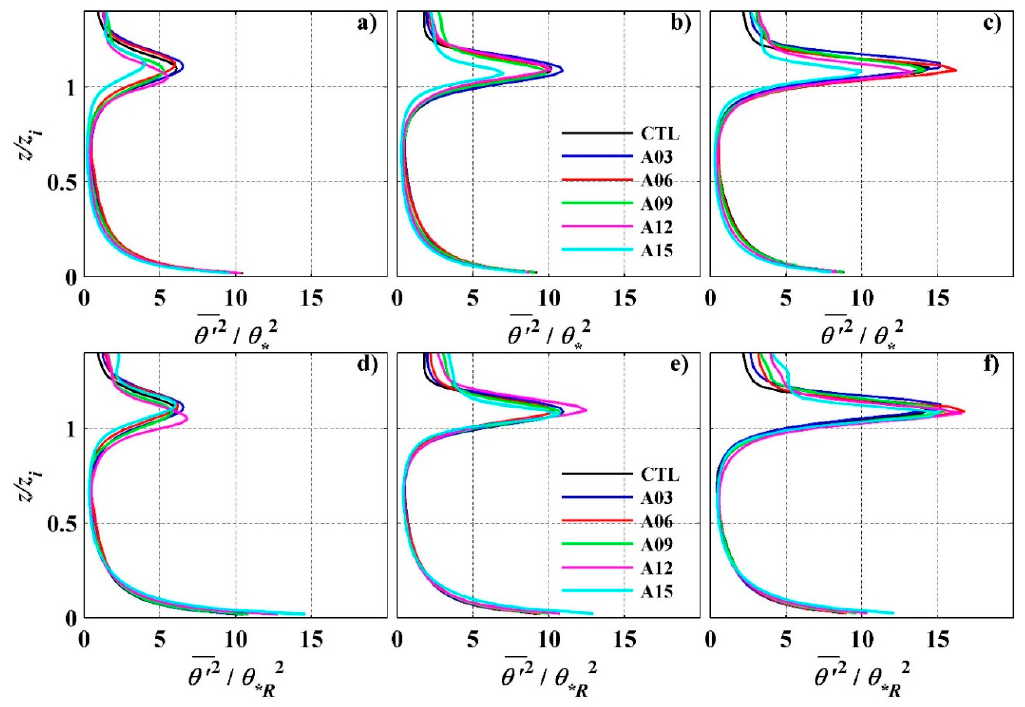
Figure 13. A comparison of profiles of the vertical velocity variance ( w (cid:48) 2 ) normalized with traditional convective velocity scale w ∗ : ( a – c ) and modified convective velocity scale w ∗ R : ( d – f ) for three different stratification strengths in the free atmosphere. For notation, see Figure 10.